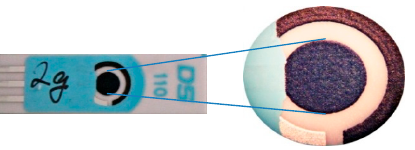
Figure 2. Aspect of the modified SPCE with poly(2,6-DHN).